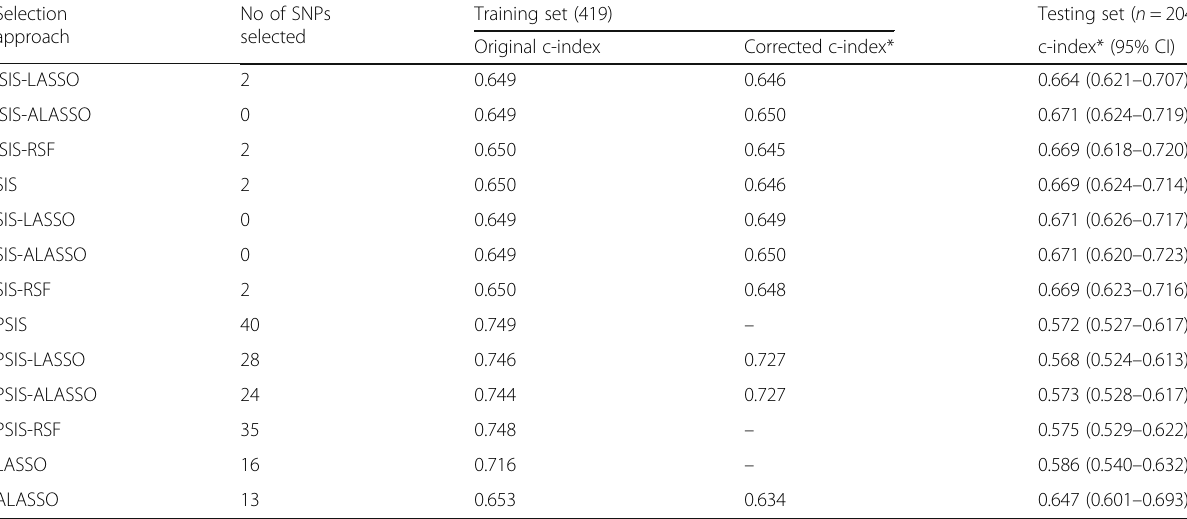
Table 7 c-indices based on the training and testing sets for the real example Selection